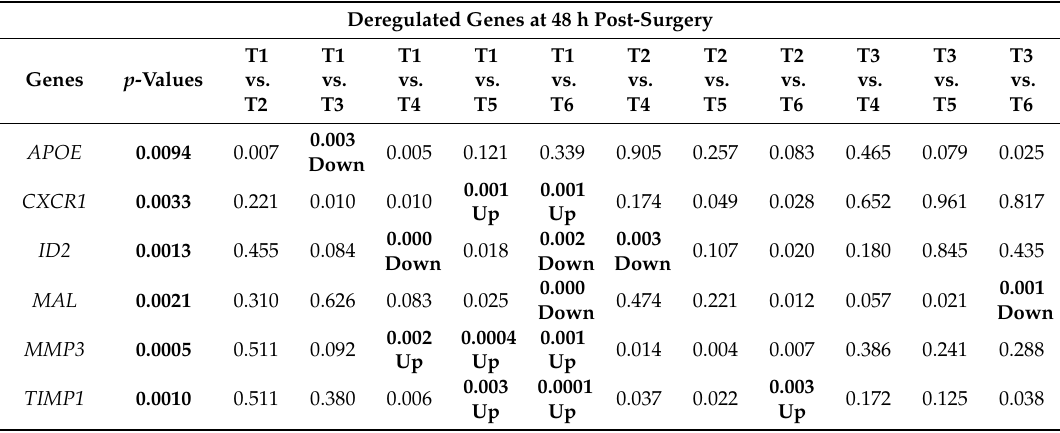
Table 9. Di ff erentially expressed genes deregulated at 48 h